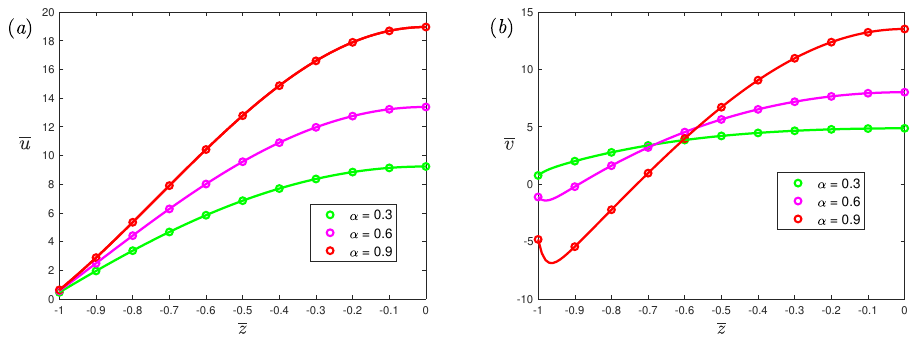
Figure 2. The dimensionless velocity profiles, ( a ) spanwise; ( b ) streamwise, of fractional Maxwell model across half channel width for different dimensionless parameters α at t = π /3, De = 5, β = 0.9, L = 0.03, K = 50, ω = 1, Ha = 0.5, G = 20, where the symbol represents numerical solutions and the curve represent the analytical